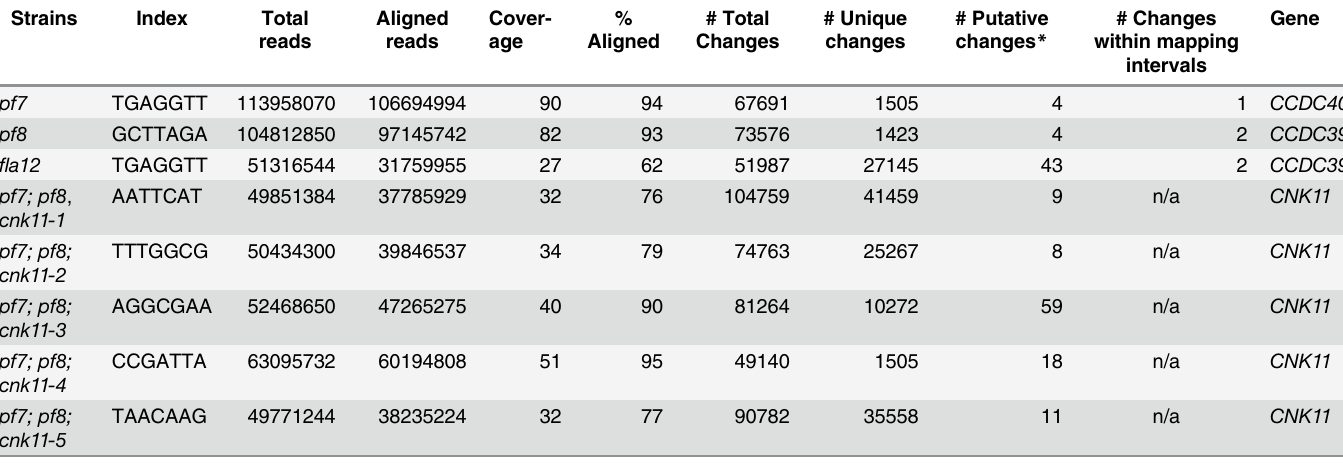
Table 1. Whole genome sequencing of mutant strains used in this study.